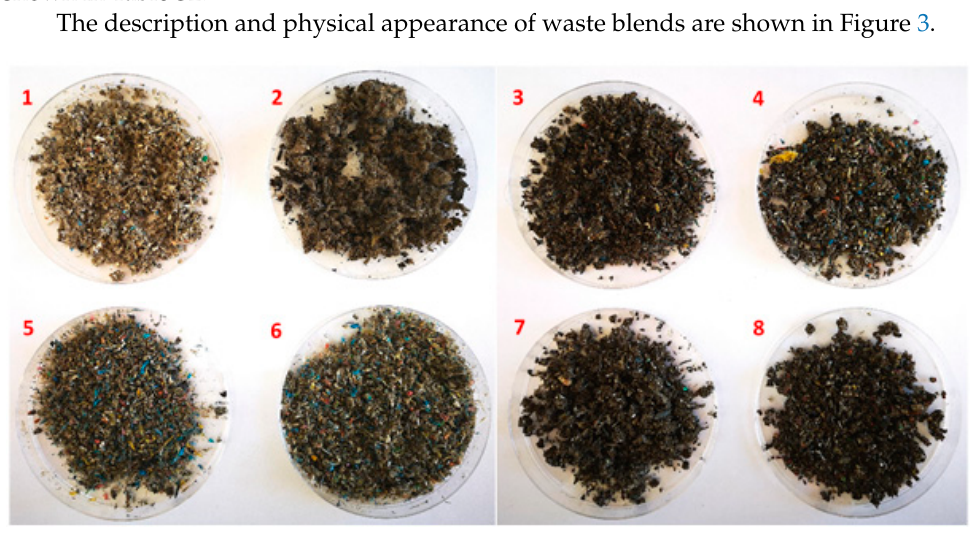
Figure 3. Visualization of 8 selected experimental waste blends (1—3RDF:SS:PR, 2—3PES:SS:PR, 3—4LDPE:SS, 4—4LDPE:2SS:PR, 5—6LDPE:SS, 6—3LDPE:SS:PR, 7—RDF:SS, 8—3TP:SS).